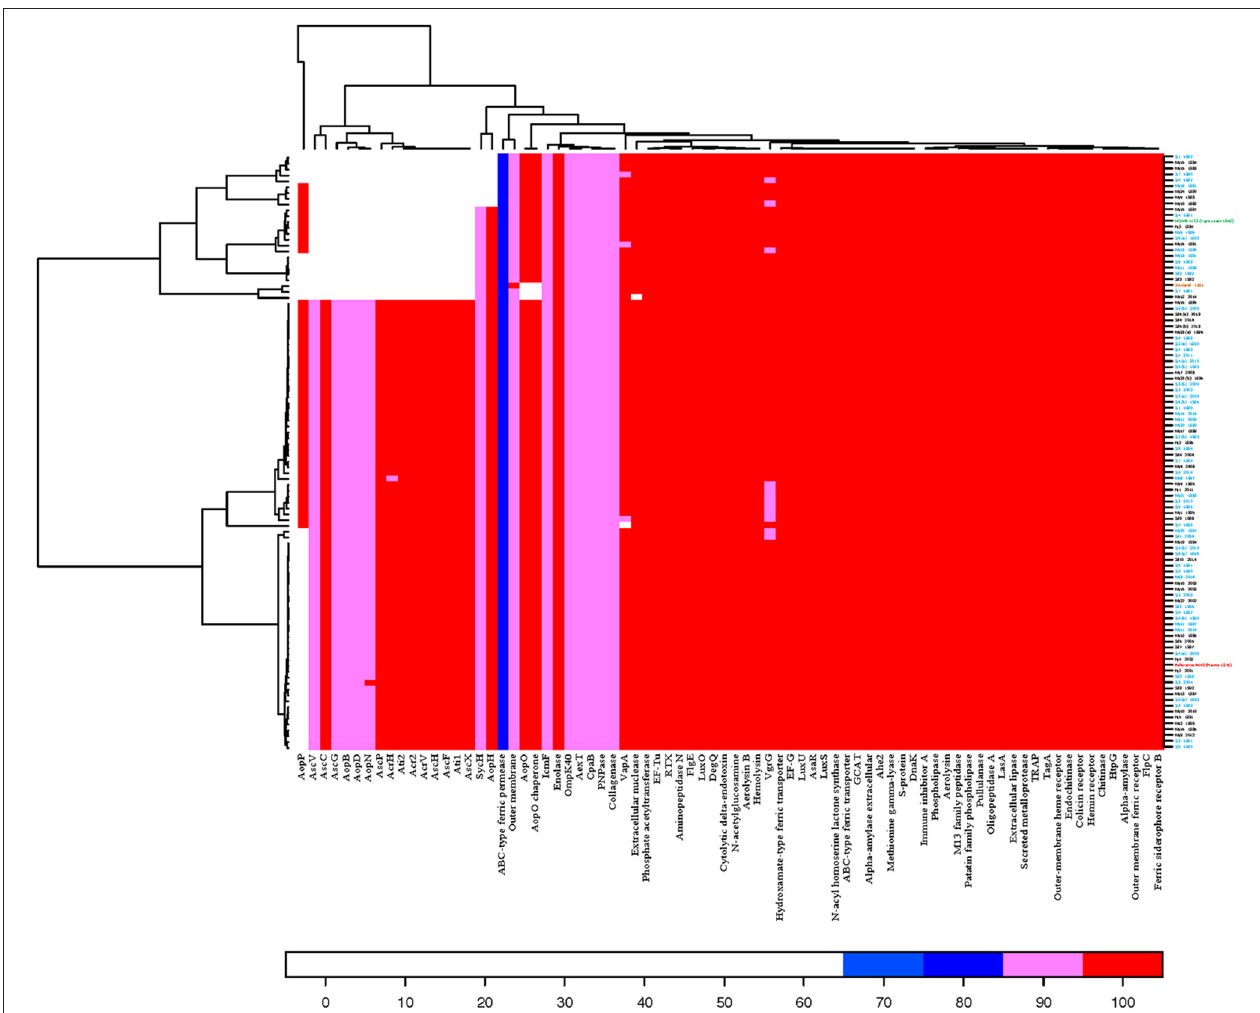
FIGURE 2 | Heatmap illustrating presence and absence of 78 virulence associated and iron acquisition protein sequences found in the NCBI protein database among the 101 A. salmonicida subsp. salmonicida sequenced isolates and the reference A449 . Isolates are displayed on the right and sequence protein names on the bottom. Threshold limit for presence of protein in an isolate was set to 65% similarity, expressed as percent sequence identity (ID) and 60% of alignment length (coverage) of the protein sequence. Red color represents > 95% ID, pink color > 85% ID, dark blue > 75% ID, and light blue > 65%